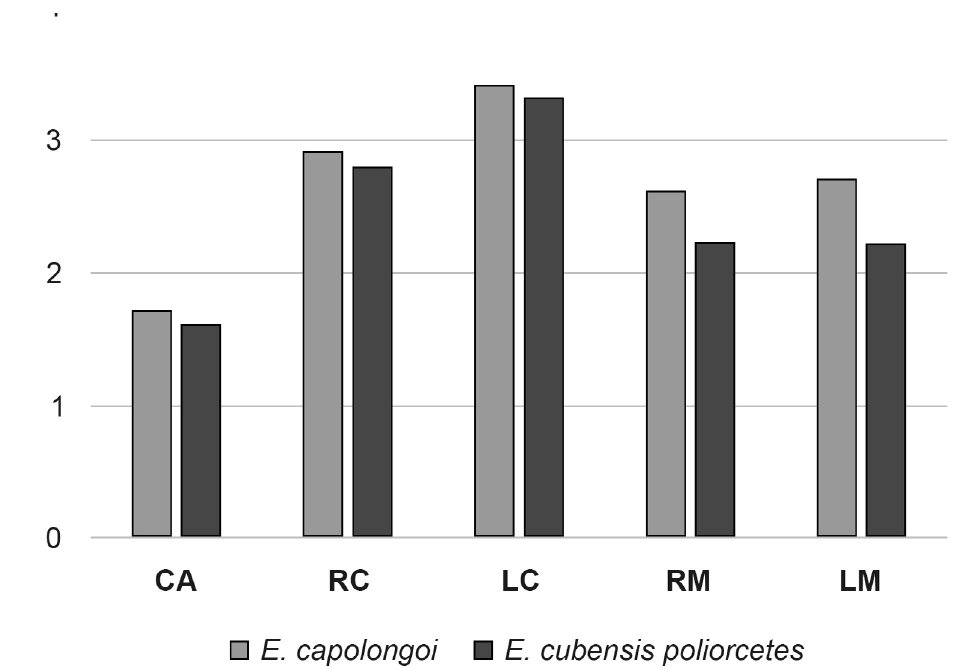
Figure 7. Variation of five morphometric ratios between Epilobocera capolongoi and E. cubensis : CA, carapace width/length; RC, right chela length/width; LC, left chela length/width; RM, right merus length/width; LM, left merus length/width (see App.